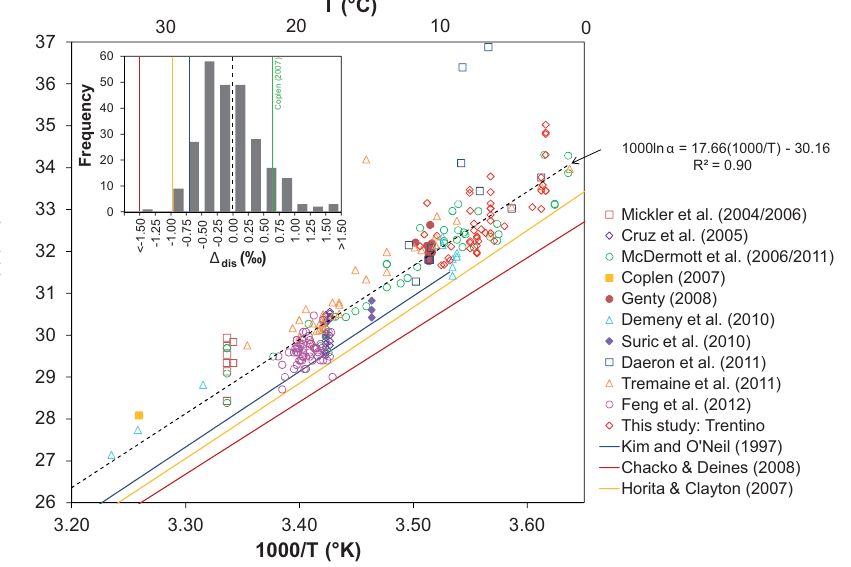
Fig. 6. Calcite-water fractionation factor (1000ln α calcite-water ) against the inverse of temperature (10 3 T − 1 ) from theoretical, laboratory and cave studies. Data from this study are plotted as red diamonds, other data points are derived from cave studies in the literature as noted in the legend and references therein (see Supplement). Solid lines are based on theoretical (Horita and Clayton, 2007; Chacko and Deines, 2008) and laboratory (Kim and O’Neil, 1997) studies. The dashed line is a linear best-fit of a compilation of all the cave calcite data giving 1000ln α =17.66(10 3 /T) − 30.16. Note that in this compilation the term cave calcite includes hot water travertines of Dem´eny et al. (2010), which although not shown here in the scale of the 1000/T axis (reaching as low as 2.94K=67 ◦ C), they are included in the calculation of the best-fit line. Inset: frequency distribution of the magnitude of possible isotope disequilibrium effects of speleothem data in main figure ( N =259). 1 dis has been evaluated as the difference between the calculated δ 18 O e and the measured δ 18 O c , with a fractionation factor based on a linear function through all the speleothem data (1000ln α =17.66(10 3 /T) − 30.16) giving a mean of 0.0 ± 0.60 (1 σ ), shown by the dashed vertical line. Use of other fractionation factors results in similar frequency distributions but with a shift in mean 1 dis , which can be visualised by a shift in position of the origin. With the fractionation factor of Kim and O’Neil (1997) 1 dis is shifted to a mean of 0.73 ± 0.61 (blue line), and using the Coplen (2007) equation, 1 dis has a mean of − 0.65 ± 0.60 (green line). Using fractionation factors derived from theoretical studies and simplified by graphical linear interpolation, 1 dis was found to average 0.98 ± 0.60 (Horita and Clayton, 2007) where 1000ln α =18.117(10 3 /T) − 32.721 (yellow line), and 1 dis was 1.5 ± 0.60 (Chacko and Deines, 2008) with 1000ln α =17.231(10 3 /T) − 30.183 (red